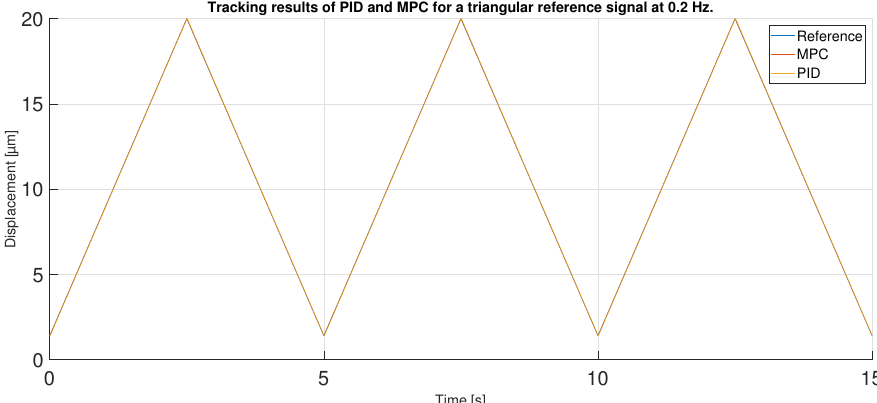
Figure 17. Tracking results of PID and MPC for a triangular reference signal at 0.2 Hz.